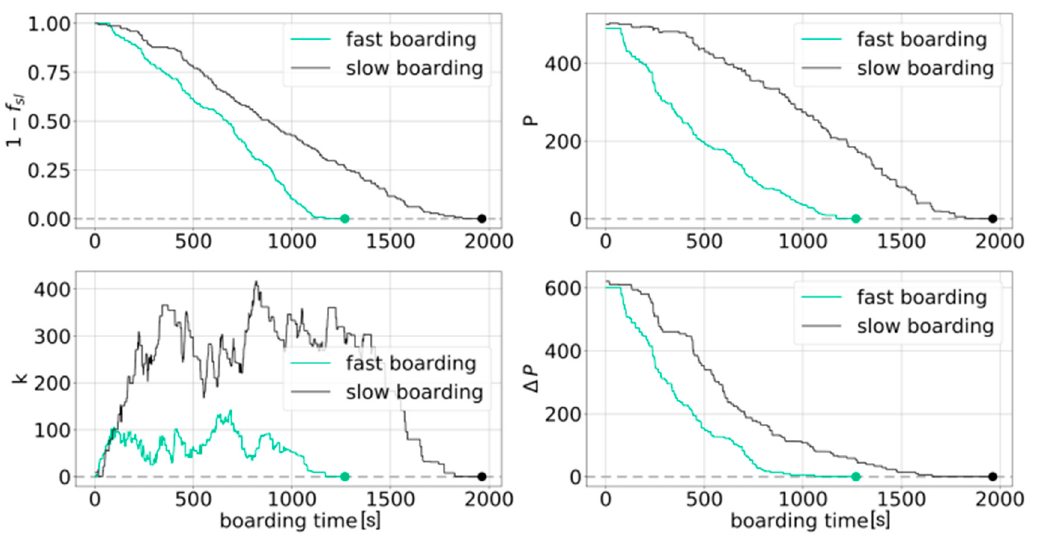
Figure 2. Complexity metric to evaluate the boarding process and progress: Seat load ( top left ), interference potential ( top right ), boarding sequence ( bottom left ), and convergence of interference potential ( bottom right ).